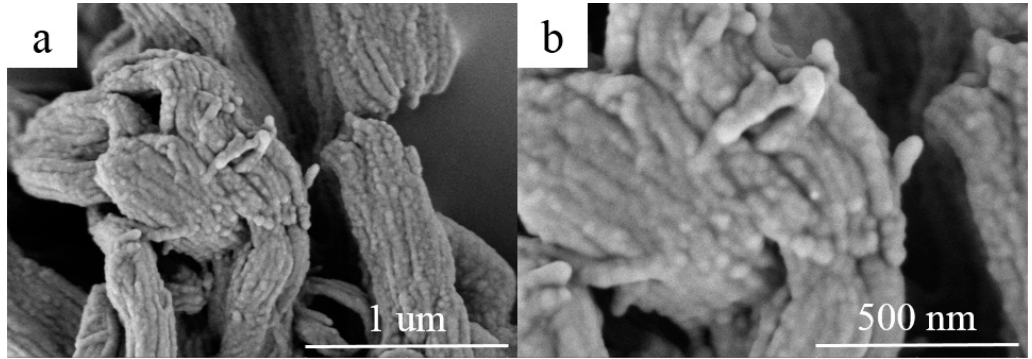
Figure 5. SEM images of A-CMK-3 based PCM ( a , b ).